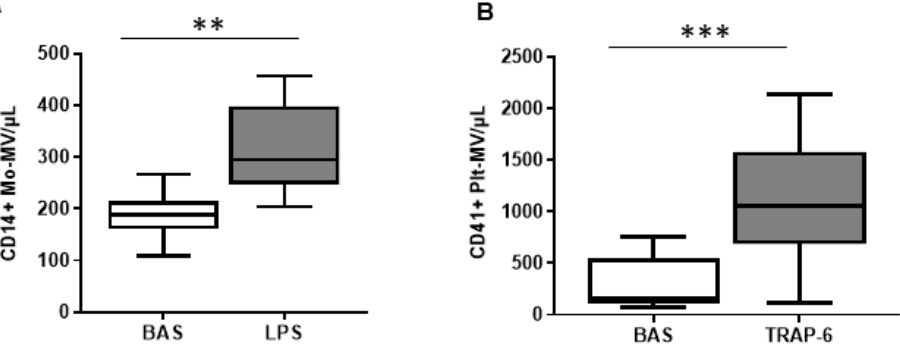
Figure 1. MVs released by monocytes and platelets isolated from healthy subjects. ( A ) Number of CD14 + MVs released by monocyte at resting conditions (basal) and after challenge with LPS 10 µg/mL ( n = 10). ( B ) Number of CD41 + MVs released by platelets at resting conditions and after TRAP-6 20 µM challenge ( n = 15). Data are represented as box and whisker plot (min to max) and analyzed by Mann–Whitney U test.** p < 0.01, *** p < 0.001 vs. resting condition.